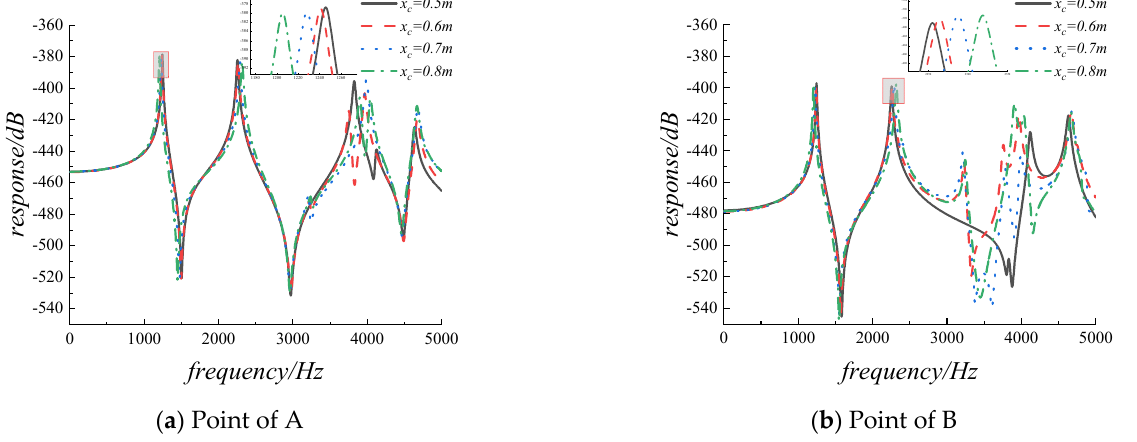
Figure 10. The displacement response for FGMs square plate with diverse cutout positions.